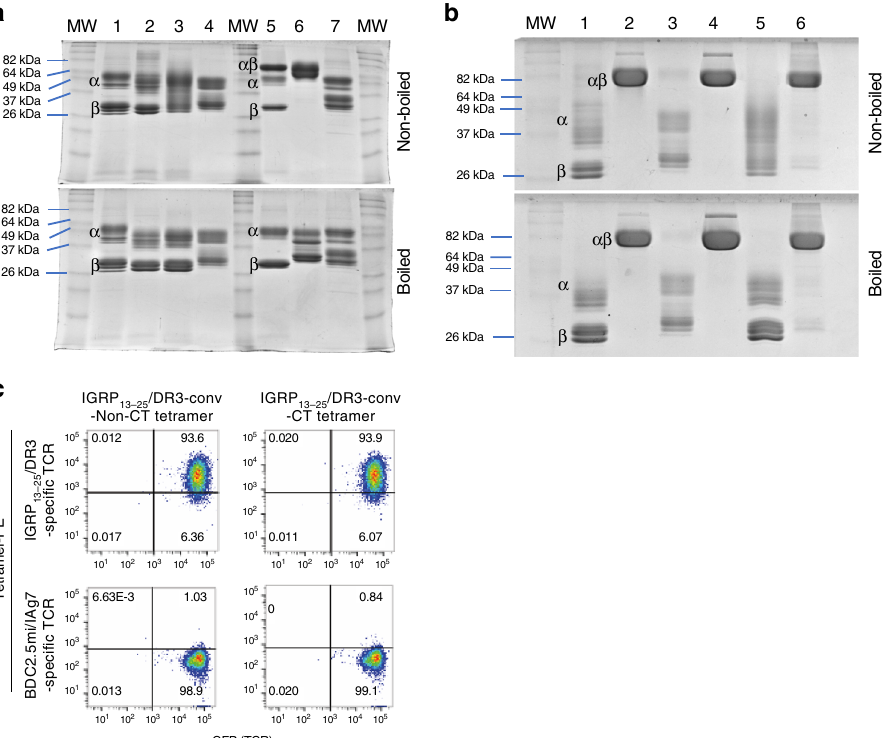
Fig. 5 Stabilization of pMHCII heterodimers by introduction of peptide-MHC α chain Cys-traps. a SDS-PAGE for various c-jun/c-fos-based pMHCII heterodimers carrying or lacking Cys-traps (CT), under native vs. denaturing conditions. 1: BDC2.5mi/IA g7 ; 2: IGRP 13 – 25 /DR3; 3: PPI (76 – 90)(88S) /DR4; 4: IGRP 23 – 35 /DR4; 5: Topo 722 – 736 /IAb; 6: ApoB 3501 – 3516 /IA b ; 7: DSG3 301 – 315/ IA b . MW, molecular weight markers. Except for ApoB 3501 – 3516 /IA b , all other pMHCII heterodimers shown are partially or completely SDS unstable. The electrophoretic behaviors of the various pMHCs shown herein were consistent with those seen with earlier preparations of the same proteins that had been previously run in separate gels at least once before. They were re-expressed, re-puri fi ed and re-run again together to generate this fi gure. b Effects of Cys-trapping on SDS stability of pMHCII heterodimers. Data correspond to 1: IGRP 13 – 25 /DR3-non-CT; 2: IGRP 13 – 25 /DR3-CT; 3: IGRP 23 – 35 /DR4-non-CT; 4: IGRP 23 – 35 /DR4-CT; 5: PPI 76 – 90(88S) /DR4-non-CT; and 6: Glia 62 – 72 /DQ2-CT. c pMHCII tetramer/CD4 FACS dot plots for Jurkat cells expressing human CD4 and an IGRP 13 – 25 /DR3-speci fi c TCR (top) or mouse CD4 and a BDC2.5mi/ IA g7 -speci fi c TCR (bottom) stained with non-CT (left) or CT (right) IGRP 13 – 25 /DR3 tetramers. The staining patterns shown are representative of at